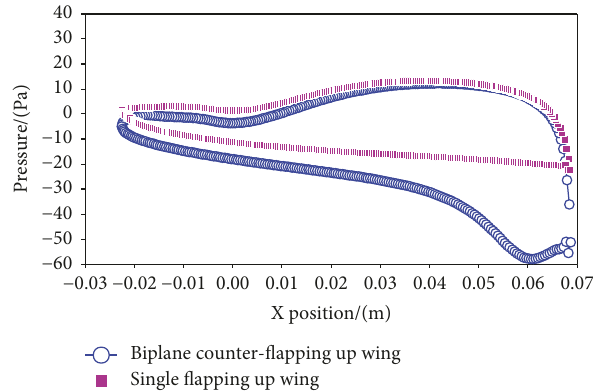
Figure 9: The pressure of the up and down surfaces of the counter- fl apping wing and single fl apping up wing at t = 5 10 T .